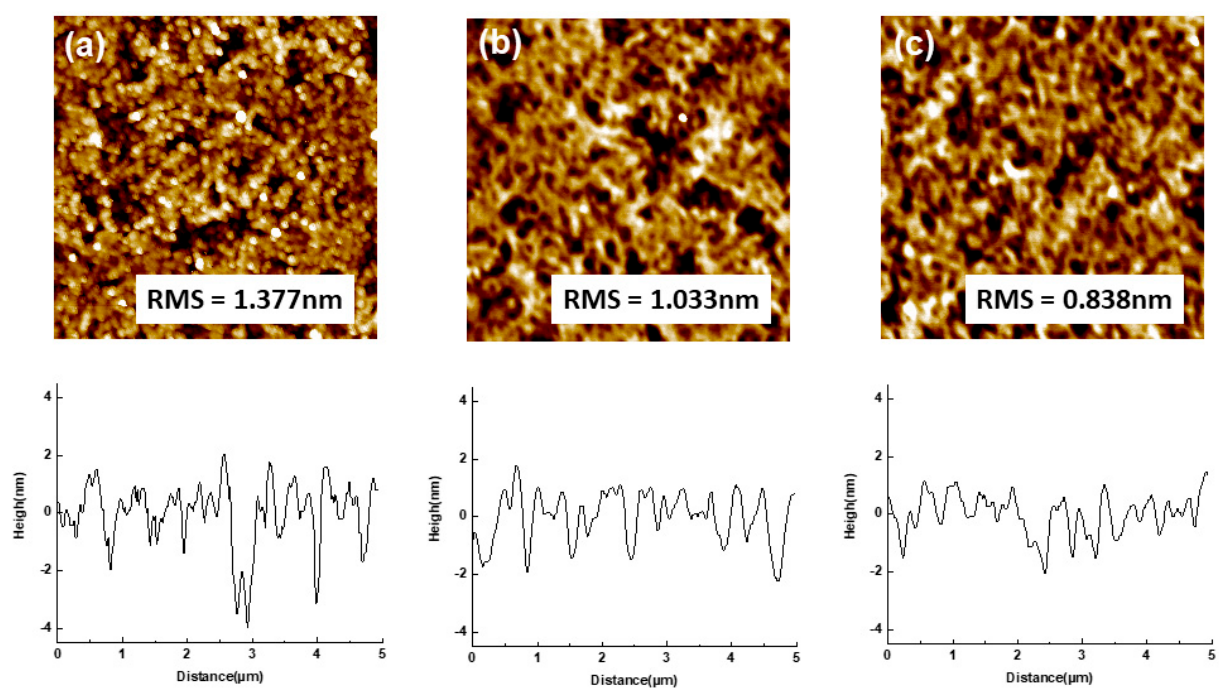
Figure 5. Average roughness, as determined by atomic force microscopy (AFM), for ( a ) ITO, ( b ) NA, and ( c ) F-10SAM. Table 1. Results of the roughness values (Mean—Mean line; Rpv—R peak to peak value, Rq—R root mean square, Ra—R average, and Rz—ten-point height).